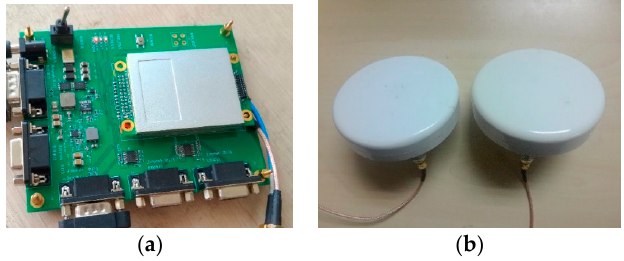
Figure 6. Experiment devices: ( a ) receiver; ( b ) antennas.